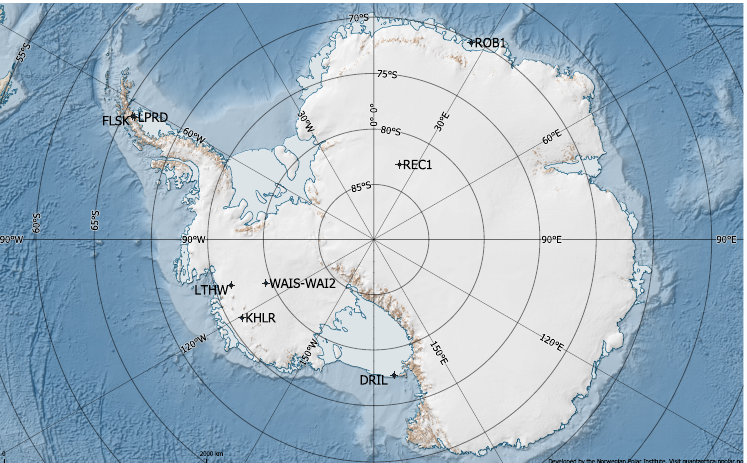
Figure 1. Map of Antarctica showing the geographical positions of the ROB1, DRIL, FLSK, LPRD, LTHW, REC1, WAIS/WAI2, and KHLR antennas. Source: Quantarctica, Detailed Basemap Norwe- gian Polar Institute,